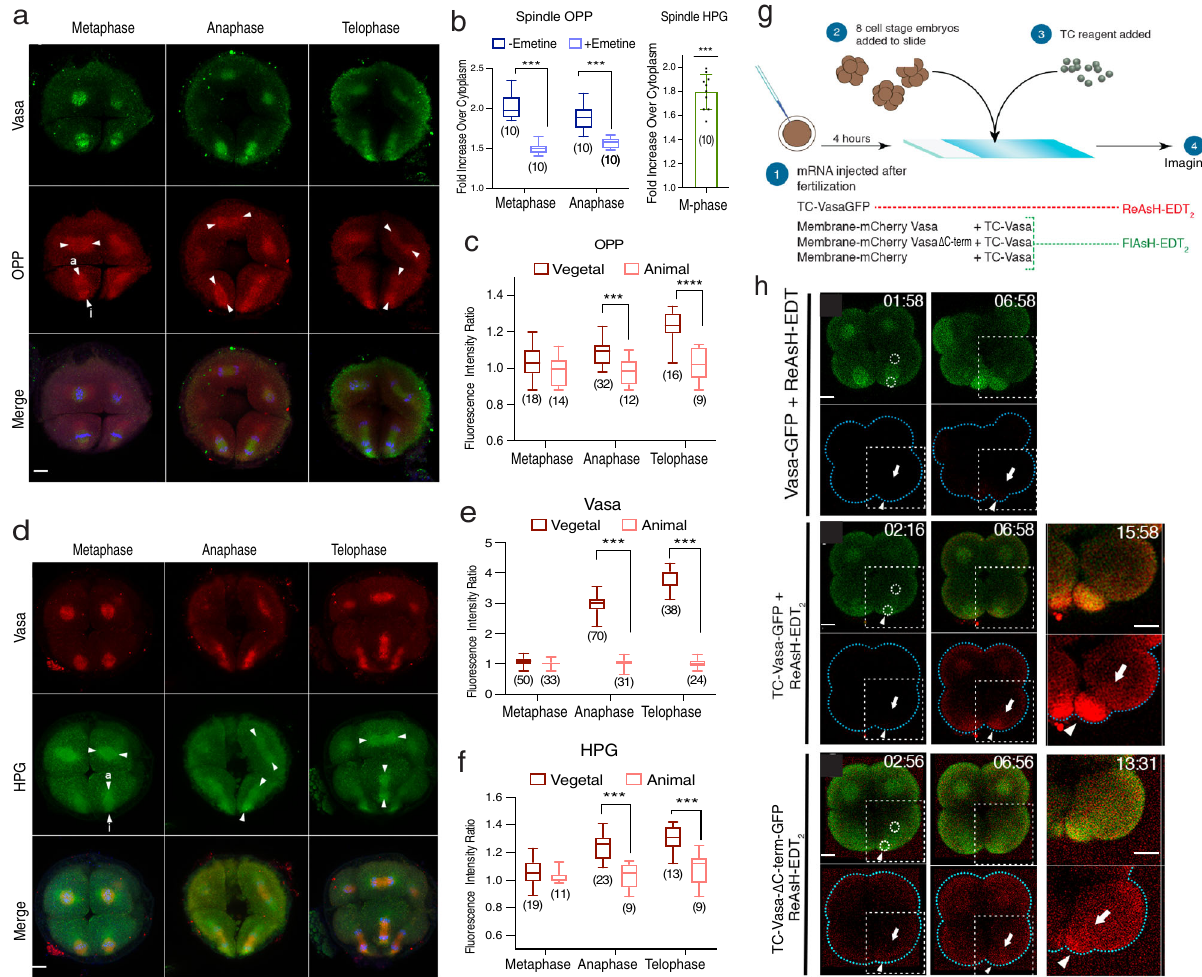
Fig. 4 In vivo or real-time detection of localized translation. a The OPP (red) and Vasa (green) staining at the 16-cell stage. i and e arrowheads indicate the micromere and macromere sides of the spindle areas, respectively, analyzed in ( c ). A whole Z-section of the cell (1 μ m per slice; ~35 slices in total) presented as a maximum 2D-projection. b (Left) % of the OPP signal on the spindle area with/without emetine (0.5 μ M). (Right) % of the HPG signal on the spindle. n = 10 for all groups. Adjusted p -value <0.0001. c The OPP level comparison between the micromere side (i) and the macromere side ( a ) of the spindle at telophase. n = 18, 14, 32, 12, 16, 9 from the left-right columns. d – f Vasa (red; e ) and HPG (green; f ) signals enriched on the micromere side (i) of the spindle compared to the macromere side ( a ). n = 50, 33, 70, 31, 38, 24 from the left-right columns of graph ( e ). n = 19, 11, 23, 9, 13, 9 from the left- right columns of graph ( f ). Adjusted p -value <0.0001. A whole Z-section of the cell (1 μ m per slice; ~35 slices in total) presented as a maximum 2D- projection. g TC-tag imaging procedure. h Live imaging of TC-tagged GFP (green) during micromere formation in 3 μ M ReAsH-EDT 2 (red): Vasa-GFP with no TC-tag (negative control), TC-Vasa-GFP (wild type), and TC-Vasa- Δ C-term-GFP (non-functional mutant). Time codes are the time post ReAsH-EDT 2 exposure. A sub-Z-section (~5 μ m) of the embryo around the spindle area was imaged every 15-s. All experiments were repeated at least three independent times. () in all graphs indicate the total number of embryos analyzed. The box plot de fi ned by two box lines indicates the 25th and 75th percentile, respectively, with a centerline at the 50th percentile and the minima and maxima whiskers. *** p < 0.001, **** p < 0.0001. Columns represent means ± SD or SEM. Two-way ANOVA was used for all statistical analyses except for the Spindle HPG ( b , right) that used paired t -test in this fi gure. Source data are provided as a Source Data fi le. Scale bars = 10 μ the spindle results in asymmetric protein synthesis over the spindle. We hypothesize that this positive reinforcing cycle is responsible for the increased translation of various mRNAs, including vasa mRNA itself. To determine how Vasa accom- plishes this function, we tested its ability to recruit other factors essential for translation, and even to nucleate translation activity.